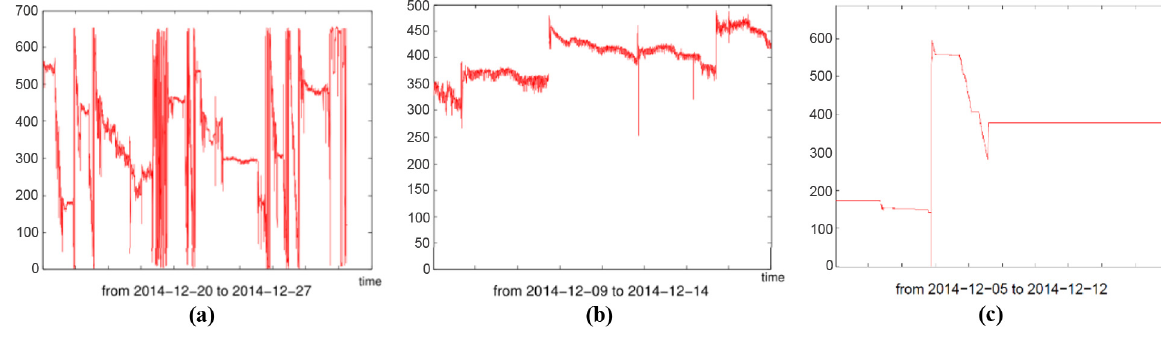
Figure 2 Typical fuel level